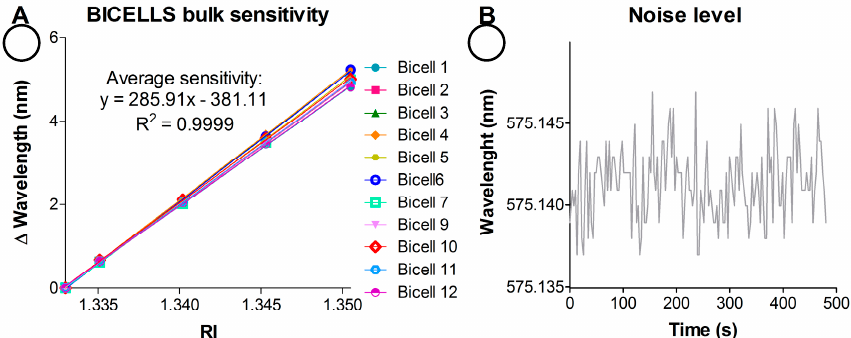
Figure 2. ( A ) BICELLs bulk sensitivity ( ∆ nm vs. RI, BICELL 8 is omitted). ( B ) Detail of signal fluctuation of one BICELL.